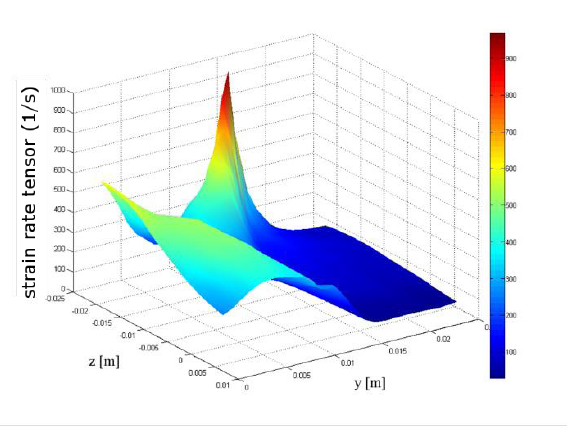
Fig. 10. Strain rate tensor magnitude